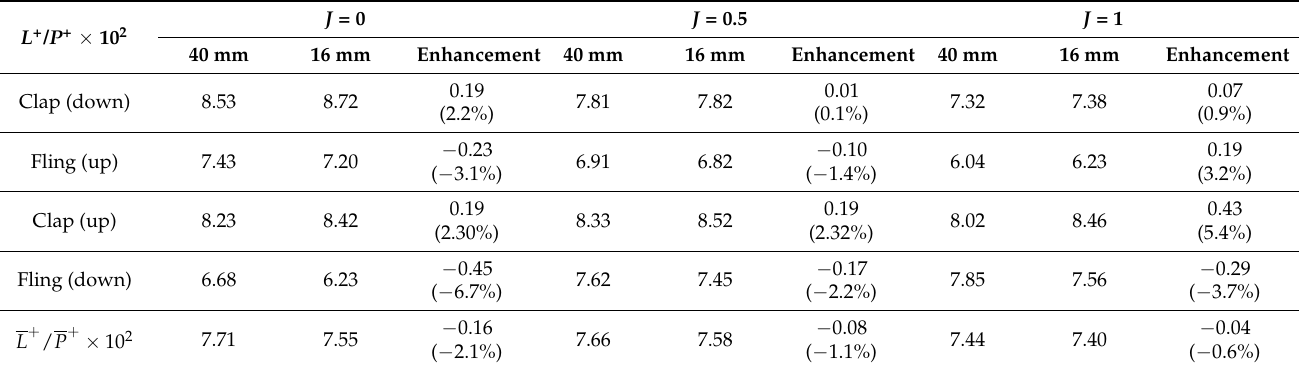
Table 5. Lift-to-power ratio of different phases and the ratio between mean lift and mean power